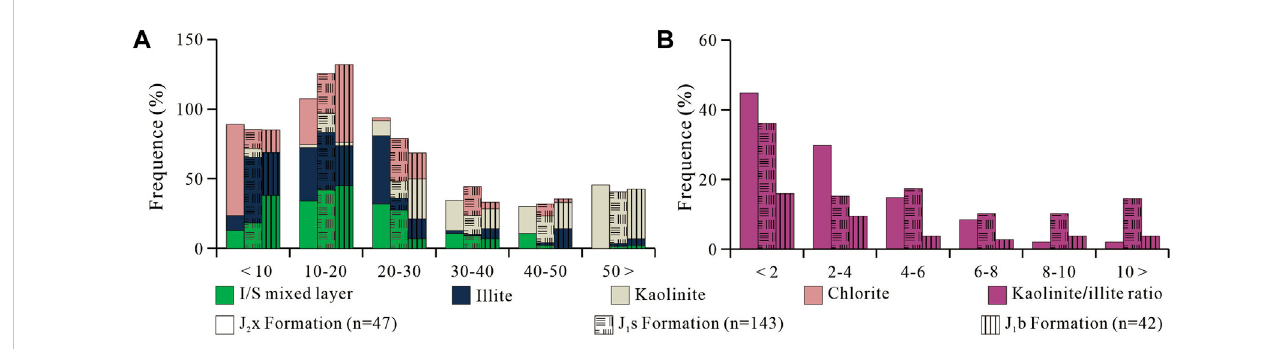
FIGURE 12 (A) Clay minerals composition and (B) kaolinite/illite ratio distribution of the Jurassic organic-rich shale in the East Fukang Sag, Junggar Basin,